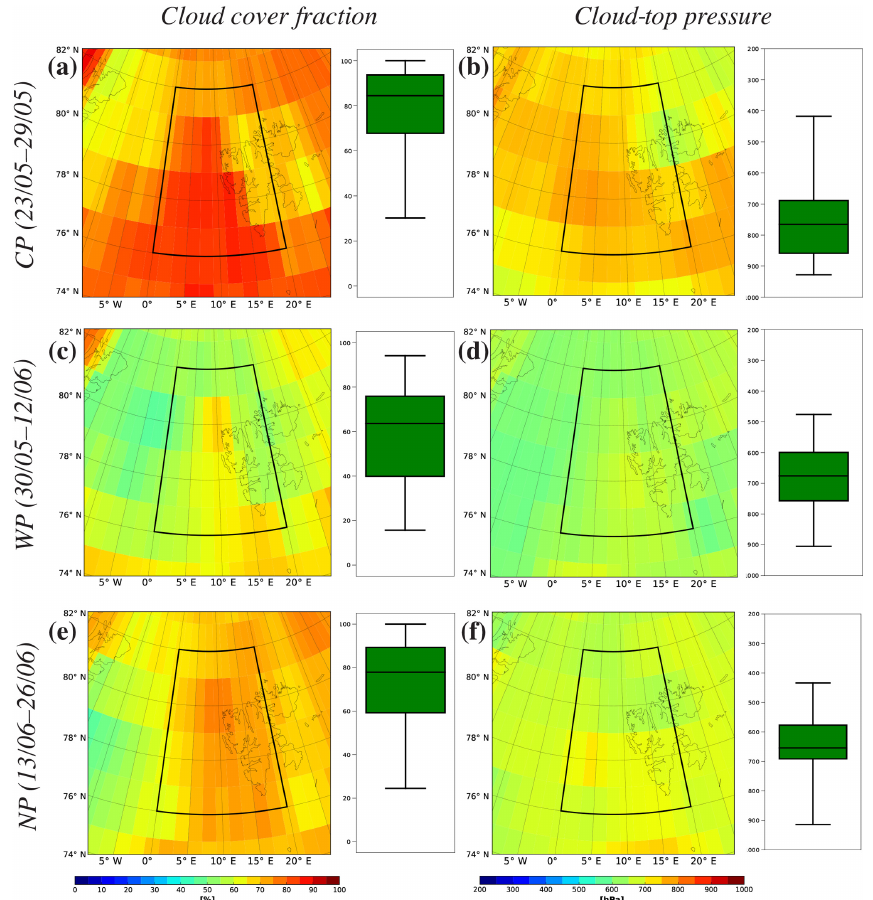
Figure 11. Average (a, c, e) cloud cover fractions and (b, d, f) cloud-top pressures for each ACLOUD/PASCAL key period from IASI. Box plots represent averages over the central ACLOUD/PASCAL region (76–82 ◦ N, 0–20 ◦ E; black boxes in map panels), with ticks indicating the 5th and 95th percentiles. The key periods are defined as (a, b) the cold period (CP), (c, d) the warm period (WP), and (e, f) the normal period